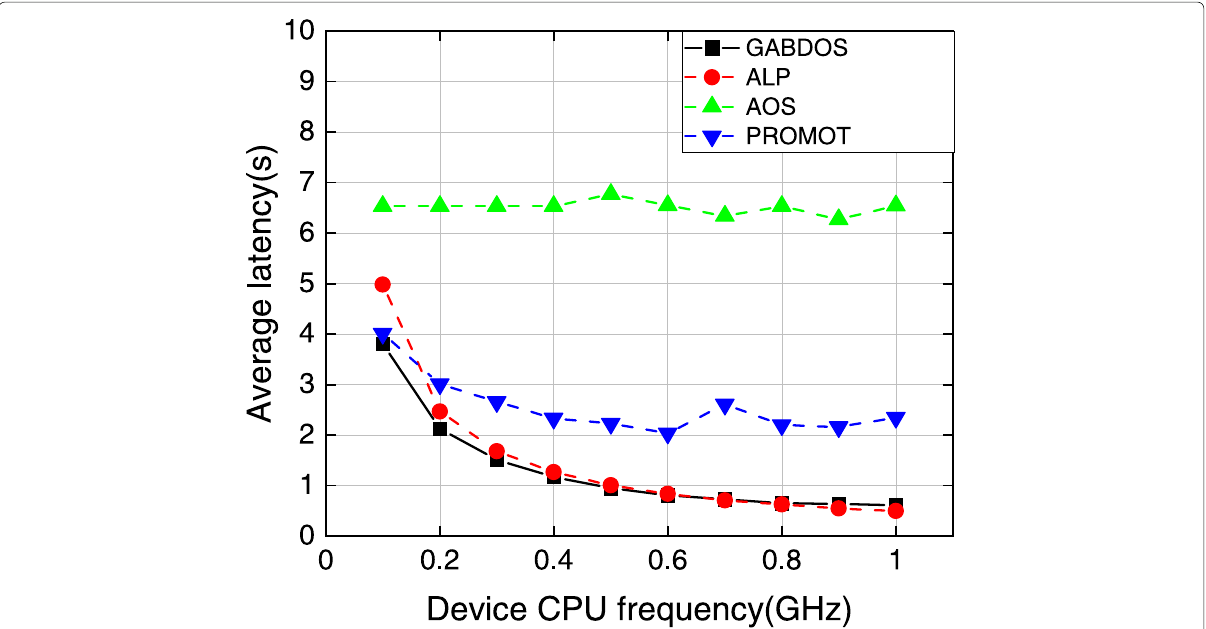
Fig. 8 Impact of user device CPU frequency on average